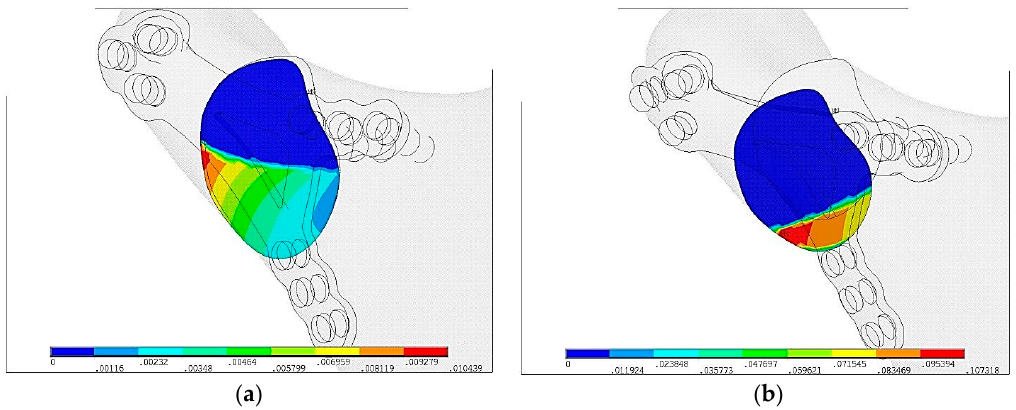
Figure 6. Displacements of bone ends just after plate fixation in the maximal loading according to the literature [16]: ( a ) Ti-6Al-4V plate fixation, u max = 0.01 mm, ( b ) PLLA plate fixation, u max = 0.1 mm.